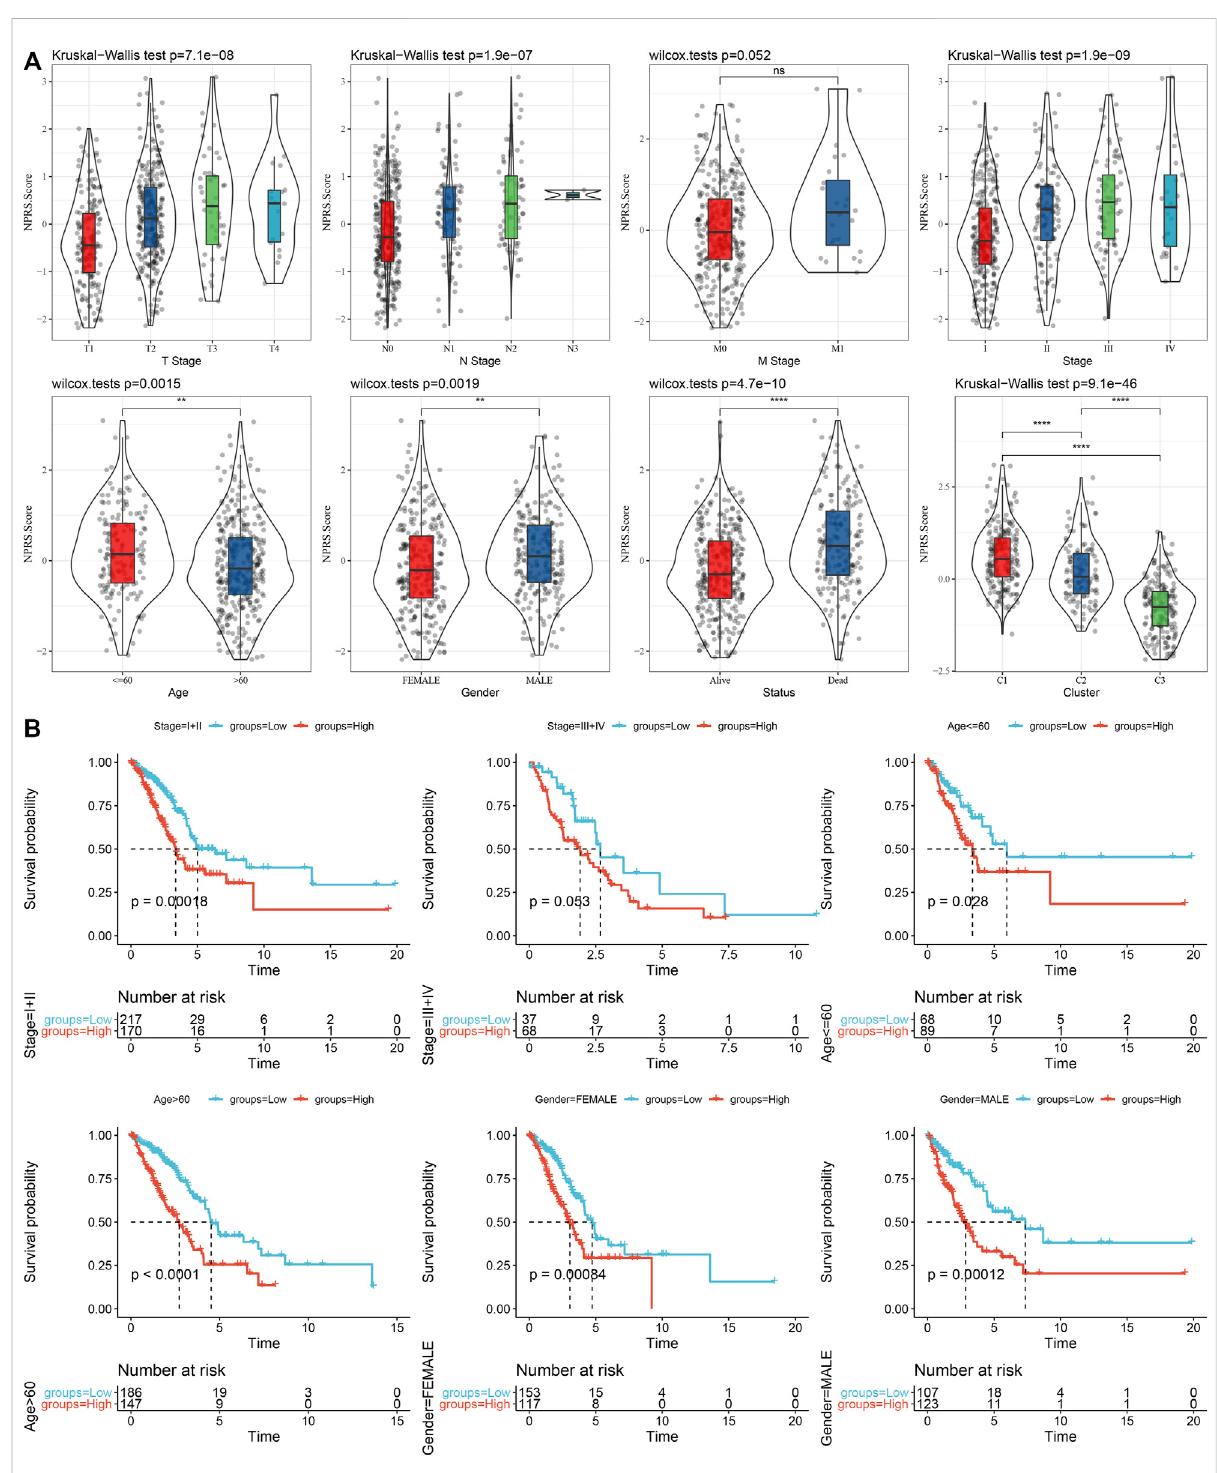
RSindifferentclinicopathologicalcharacteristics. (A) ThedifferenceofRSbetweendifferentclinicopathologicalgroupsoftheTCGAcohort; (B) KM curve between RS-high and -low groups among different clinicopathological groups of the TCGA